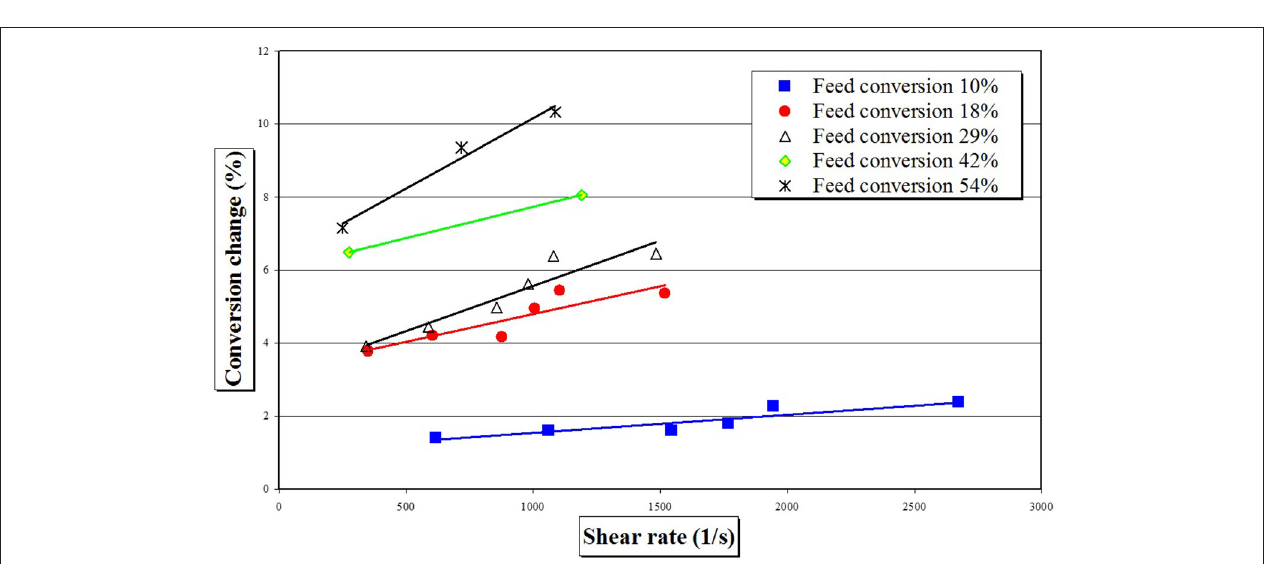
FIGURE 7 | Conversion change with residence time for free-radical styrene polymerization after one SDR pass at 90 ◦ C and feed flow rate of 6 cm 3 s − 1 .